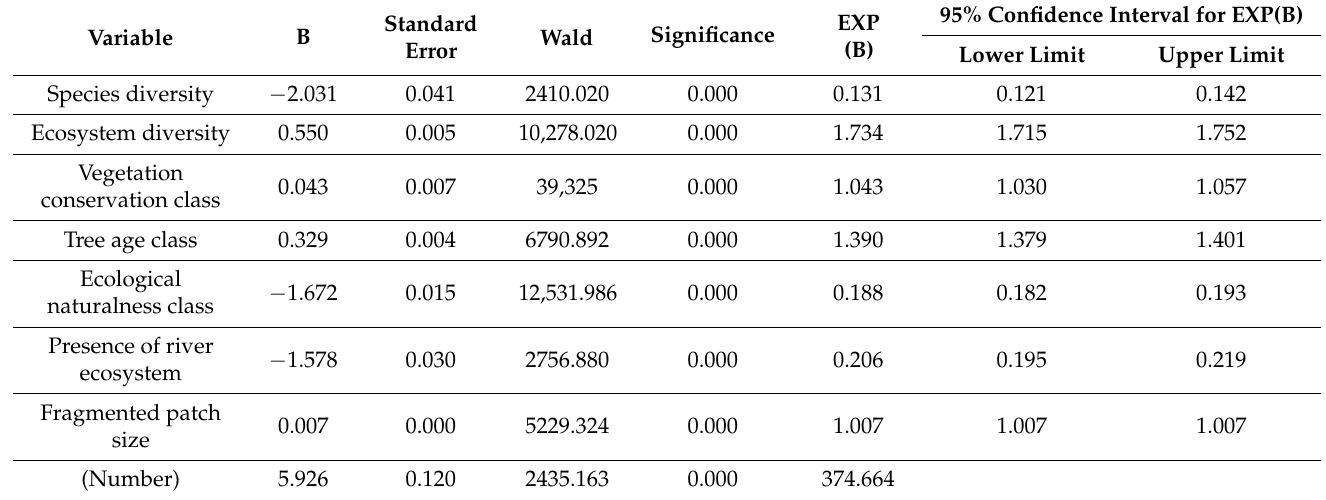
Table 3. Results of logistic regression analysis of seven